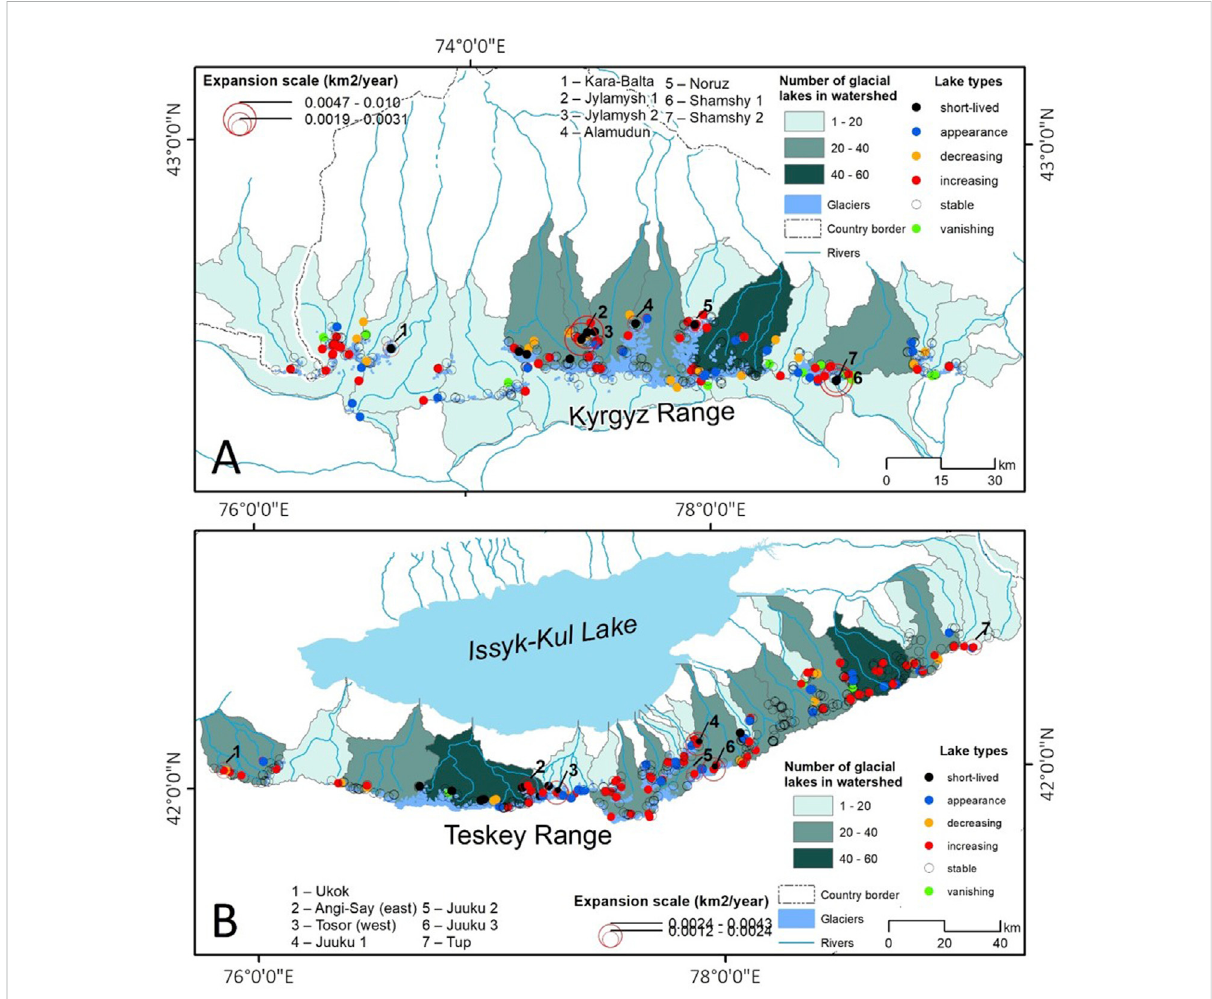
FIGURE 3 Lake type distribution by watershed in Kyrgyz (A) and the Teskey (B) ranges. A circle in red color shows the location of 14 large expansion